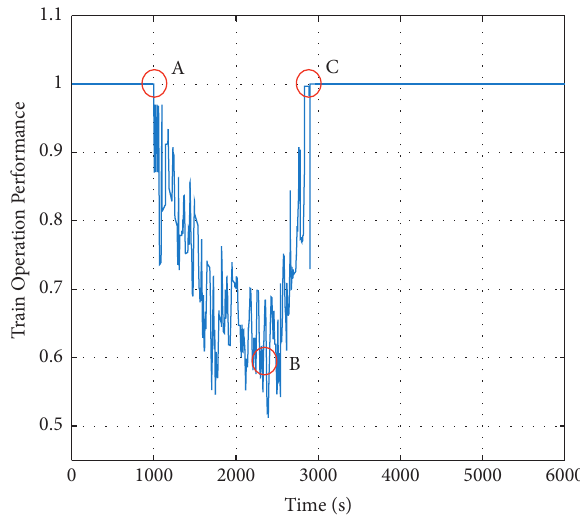
Figure 10: The train operation performance of the subway line under scenario